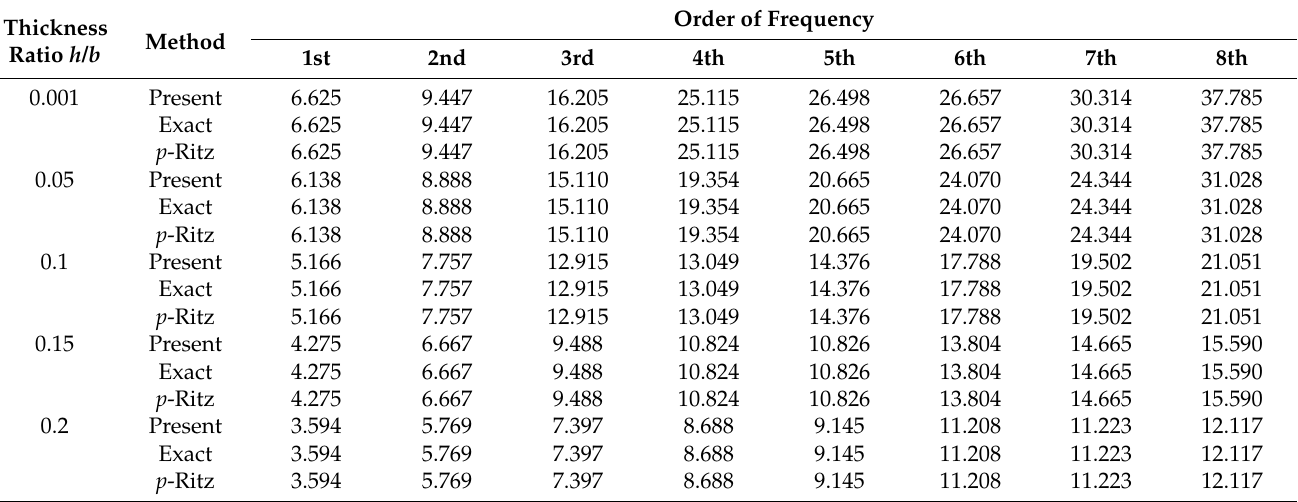
Table 5. The nondimensional frequency Ω for SSSS laminates.